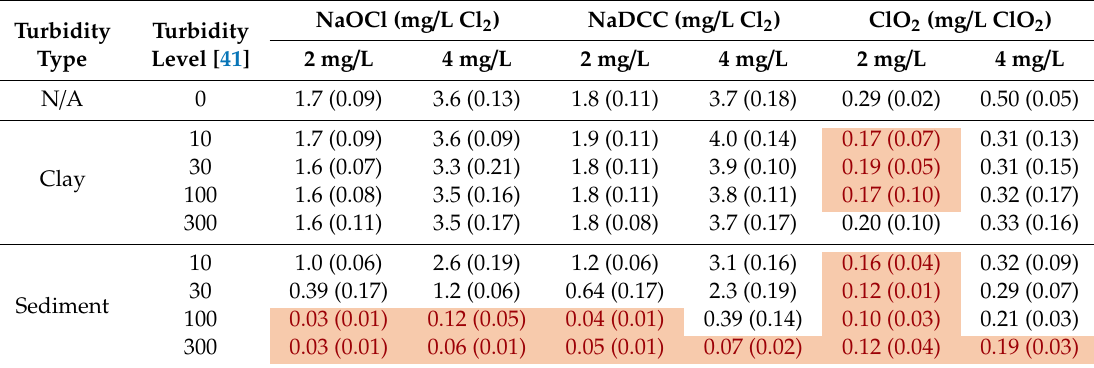
Table 3. Mean (standard deviation) disinfectant concentration after 24 hours (n = 6, duplicates at three added TOC levels for each turbidity and dosage